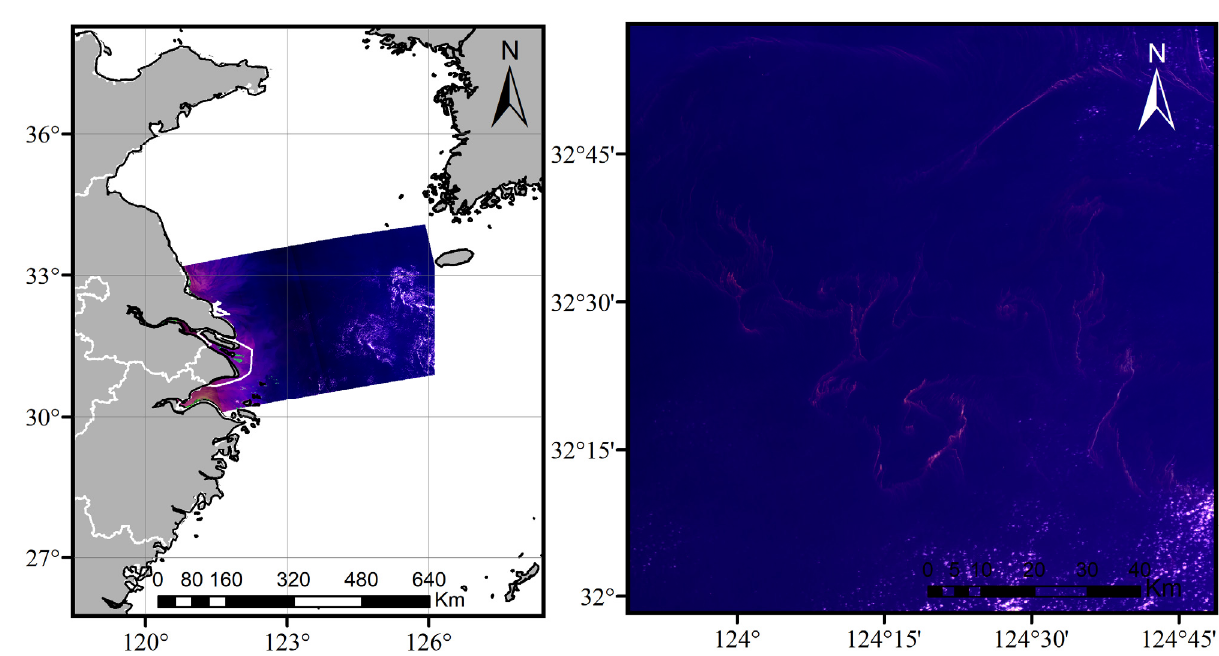
Figure 1. CZI FRGB image with NSB acquired on 17 August 2020. Table 1. Information on NSBs in CZI.